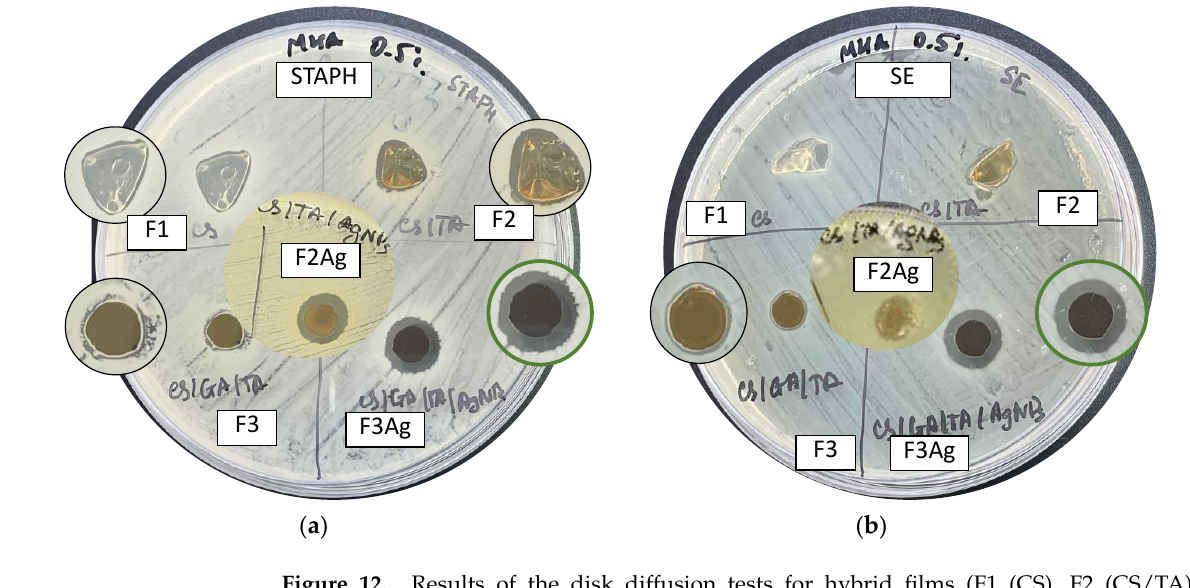
Figure 12. Results of the disk diffusion tests for hybrid films (F1 (CS), F2 (CS/TA), F2Ag (CS/TA/AgNPs), F3 (CS/GA/TA), F3Ag (CS/GA/TA/AgNPs) against ( a ) S. aureus and ( b ) S. enterica . Table 5. Summary of zone of inhibition diameters of thin fresh and aged polymer films after disk diffusion assay. The initial sample diameter is 0.6 cm.